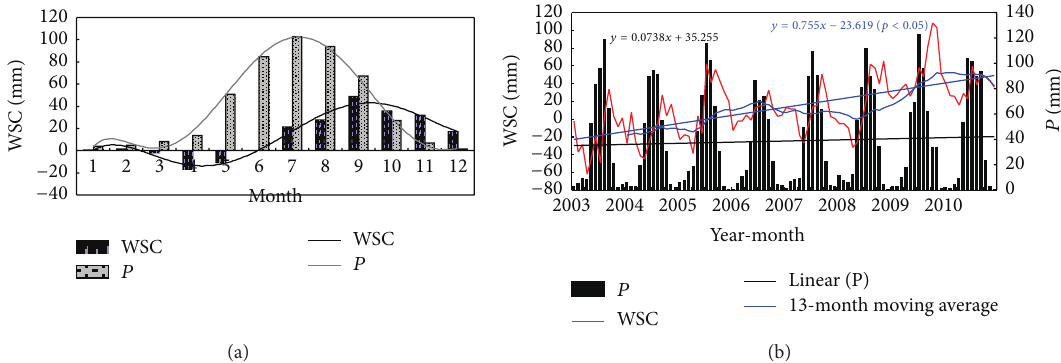
Figure 3: (a) Annual distributions of WSC and (b) time series of water storage change (WSC) and precipitation ( 𝑃 ) over the Three-River Source Region during